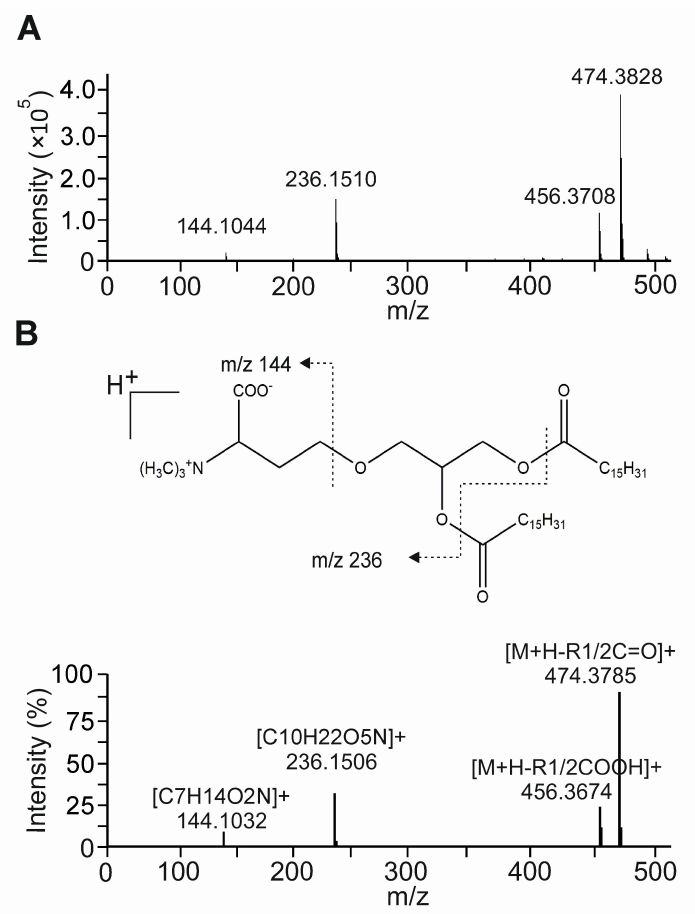
Figure 7. MS/MS analysis of DGTS species identified in NAE_2022C. ( A ) Representative MS/MS spectrum of [M + H] + ion at m / z 740.6 of DGTS identified in the active fraction (F7 + F8) of NAE_2022C. ( B ) MS/MS spectrum and fragmentation pattern of [M + H] + ion at m / z 712.6 of DGTS (16:0–16:0) standard